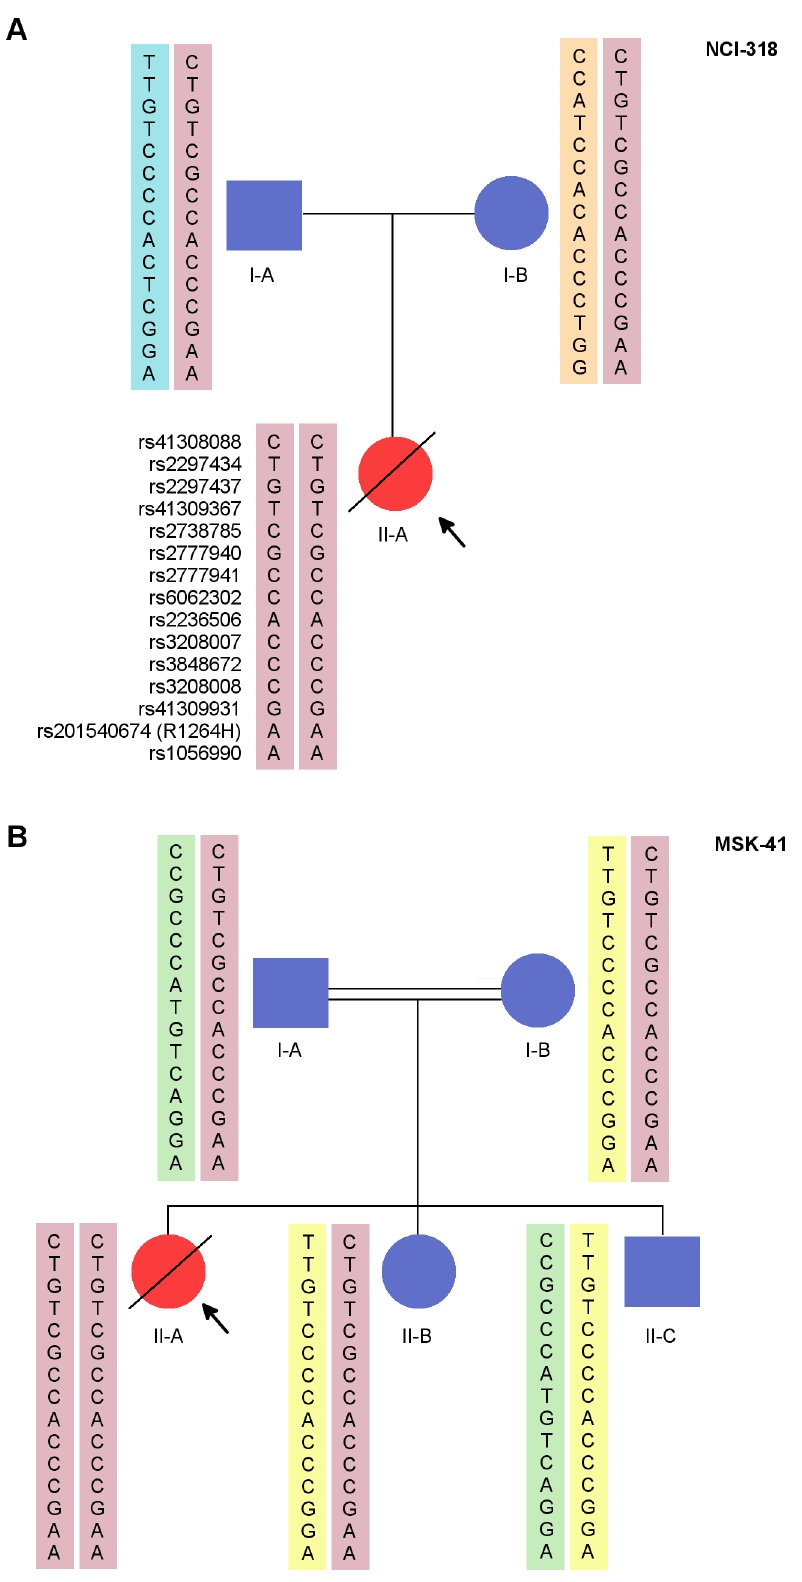
Figure 1. NCI-318 and MSK-41 pedigrees with RTEL1 mutation and shared risk haplotype. NCI-318 (A) and MSK-41 (B) pedigrees are shown. Red symbols indicate affected individuals. The pink rectangles indicate the shared haplotype between the pedigrees. Each other colored rectangle indicates a unique haplotype.